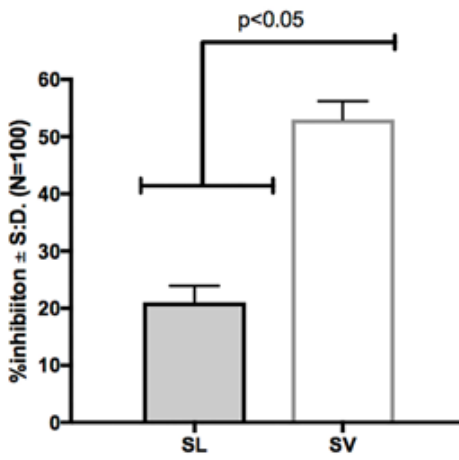
FIGURE 1 - The germ tube inhibiton percentage of C. albicans ATCC 90028 after treatment with extracts of Sternbergia spp. Legend: SL= Sternbergia lutea, SV= Sternbergia vernalis extract; All results were obtained with concentration of 90 µ g/mL.